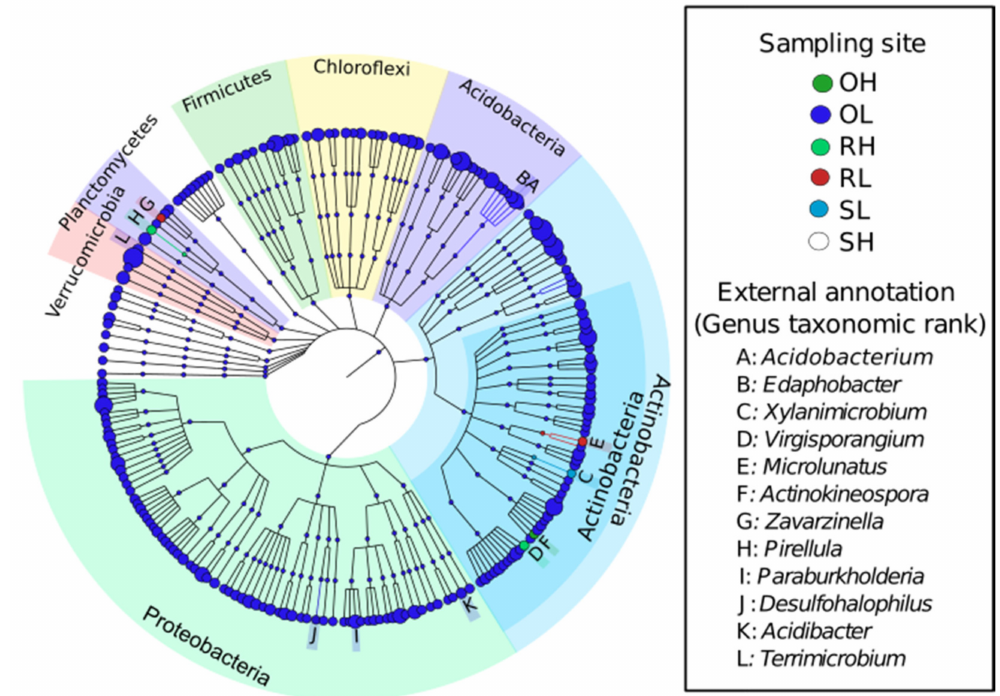
Figure 5. Differentially abundant genera assessed using LEfSE. Only genera with a LDA score > 2.0 and Kruskal-Wallis p < 0.05 are